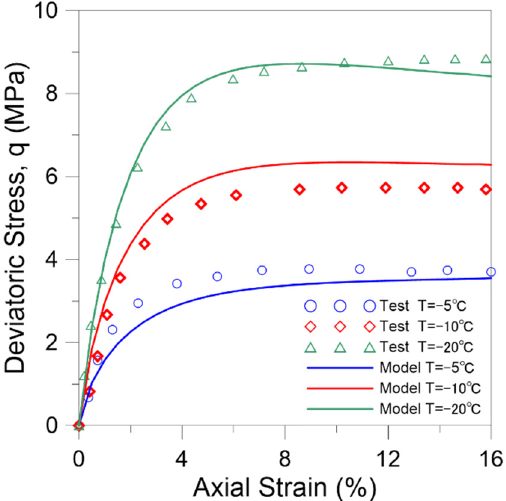
Figure 10. Modeling the tests reported in Li et al. [96] at different temperatures, deviatoric stress versus axial strains.